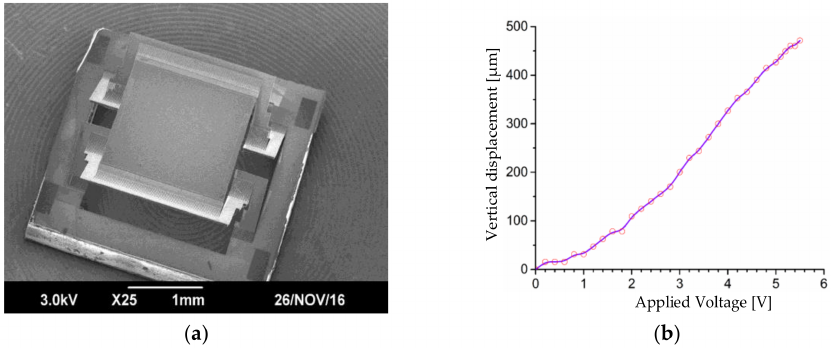
Figure 1. The MEMS micromirror under investigation. ( a ) SEM of the micromirror; ( b ) The measured vertical displacement vs. applied